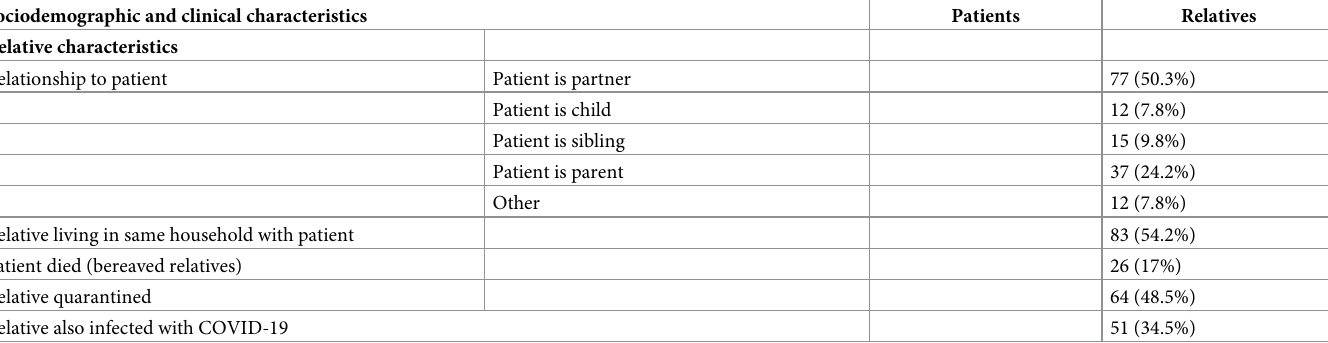
Table 2A and 2B give a detailed overview of the associations with psychological distress for